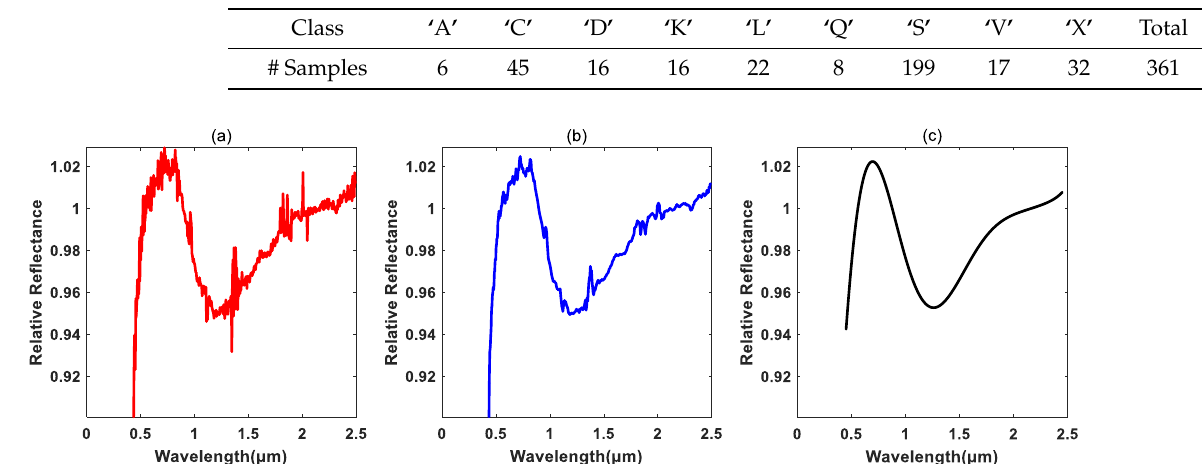
Table 3. Description of asteroid spectral datasets used in the experiments.